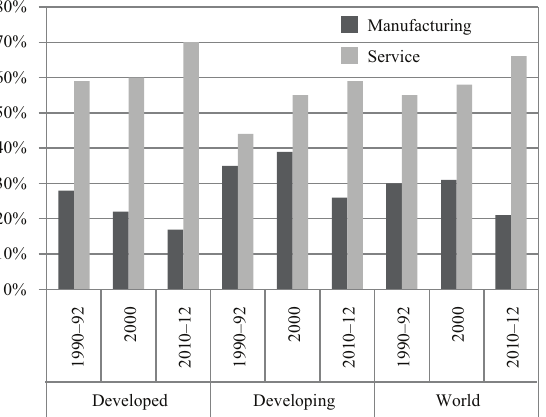
Fig. 1. Trends in the sectoral composition of FDI inflows: share of each sector in total FDI inflows, 1990–2012 Source: Own elaboration based on World Investment Report (see UNCTAD